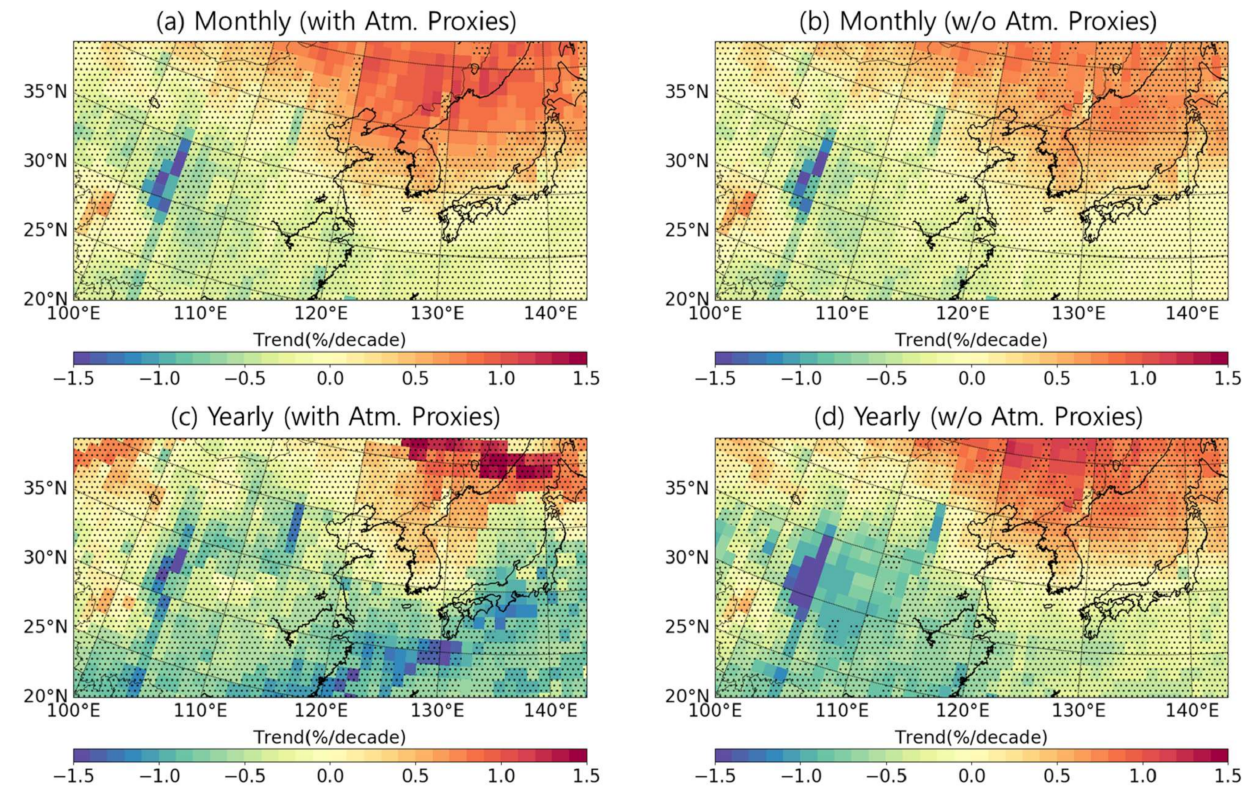
Figure 9. Trend distribution in East Asia from 1997–2020. The left panels show the trends using the atmospheric proxies ( a , c ), while the right panels do not ( b , d ). The top and bottom panels show the trends from the monthly ( a , b ) and yearly ( c , d ) variability, respectively. The dotted pattern denotes areas where trends are not statistically significant at the 2-sigma level.